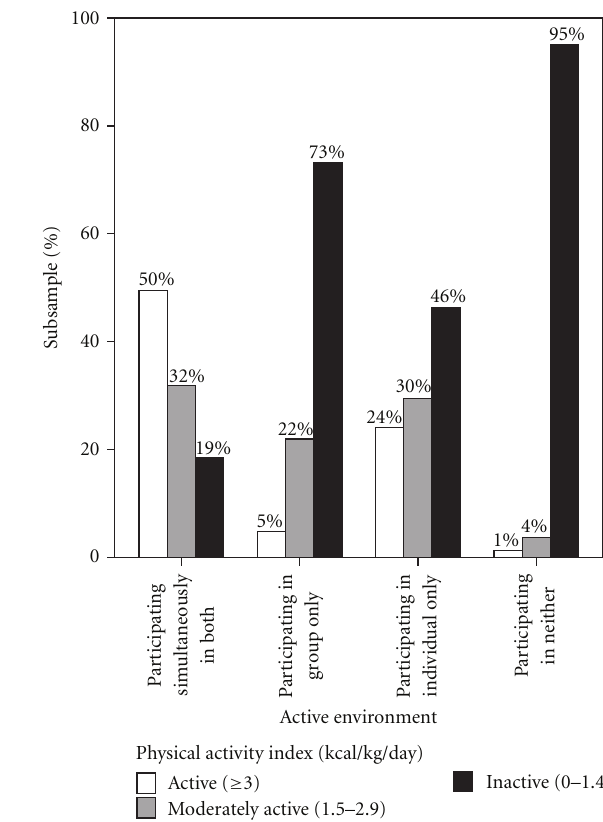
Figure 1: Percentage of participants participating in active environ- ments stratified by daily energy expenditure